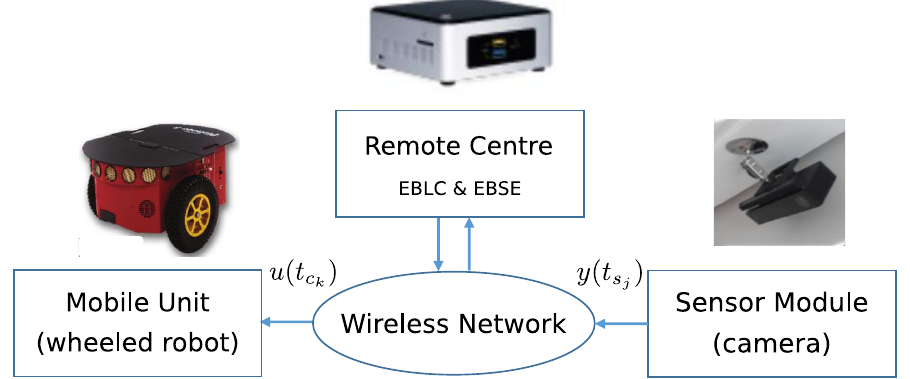
Figure 1. Main elements involved in event-based sensing and control for P3-DX guidance implemented on a remote